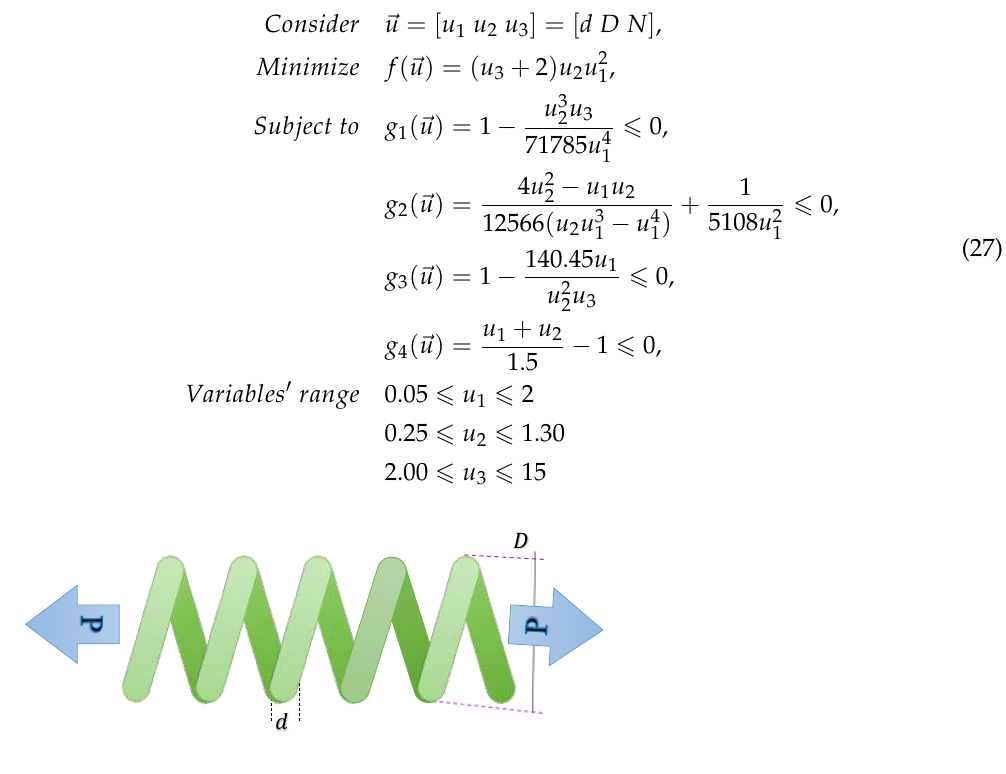
Figure 3. Design of the TCSD problem.